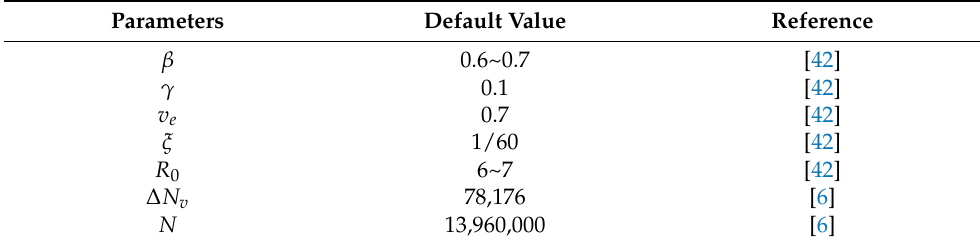
Table 5. Parameter settings for SIQRV model in base case.